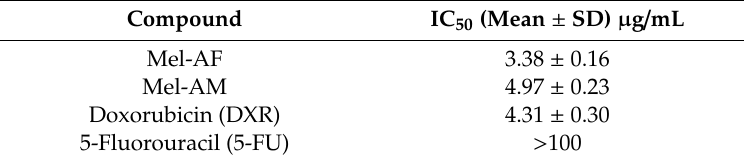
Table 1. IC 50 values of melittin and anticancer drugs on A375 cells.